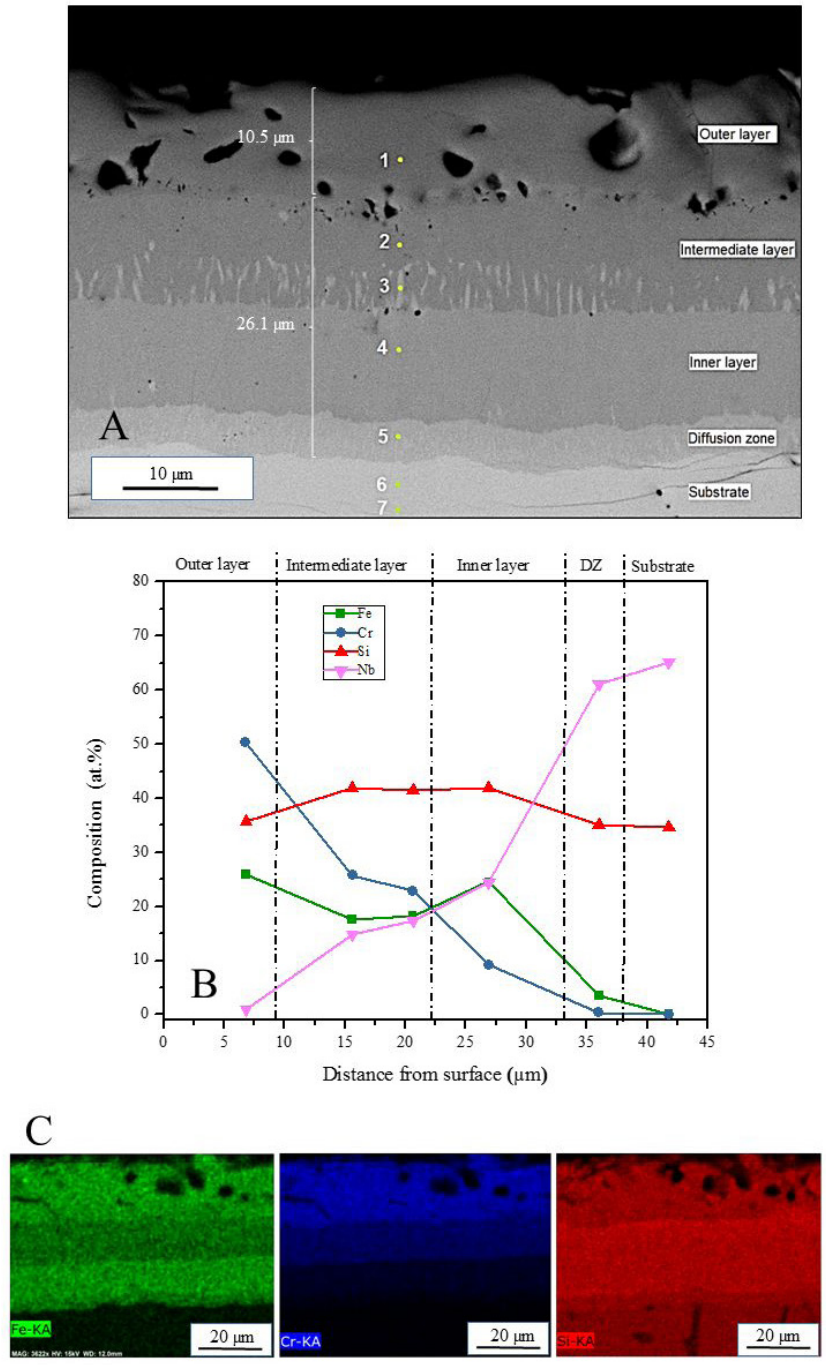
Figure 4. A Cross section by SEM/BSE image of the coating formed at 1200 °C for 12 h in a pack mixture of 60 wt. % (Fe-Cr-Si masteralloy)- 40 wt.%